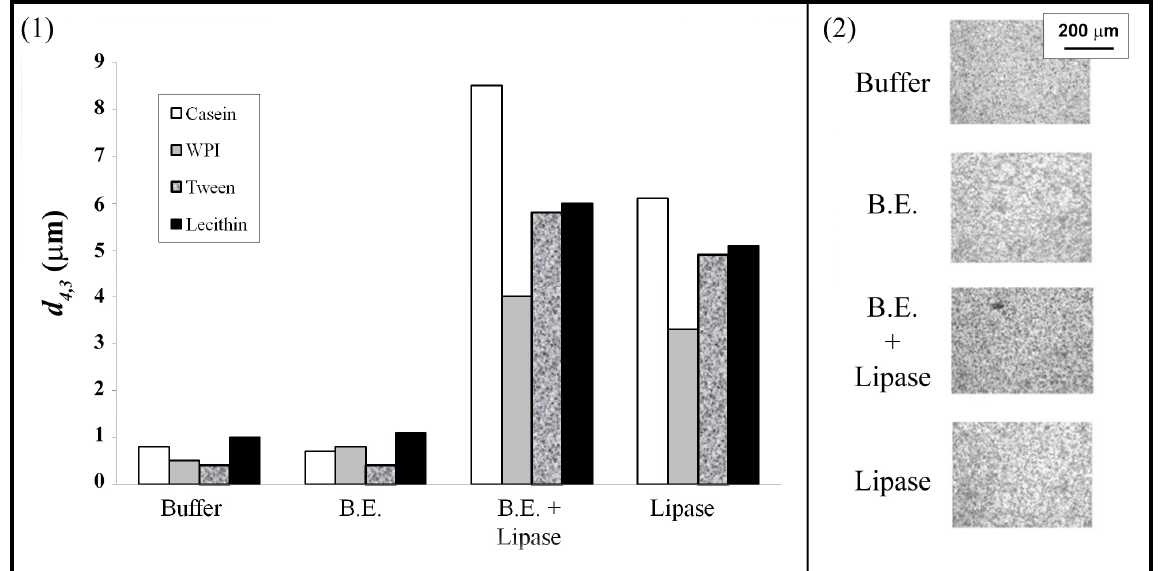
Figure 6. Influence of bile extract (B.E.) and lipase on ( 1 ) the mean particle diameter ( d of 3 wt% corn oil-in-water emulsions (0.6 wt% sodium caseinate, WPI, Tween 20 and lecithin), and ( 2 ) the microstructure of 0.6% lecithin-stabilized emulsion (5 mM phosphate buffer, pH 7.0). Adapted with permission from Mun et al. [109], Copyright (2007)